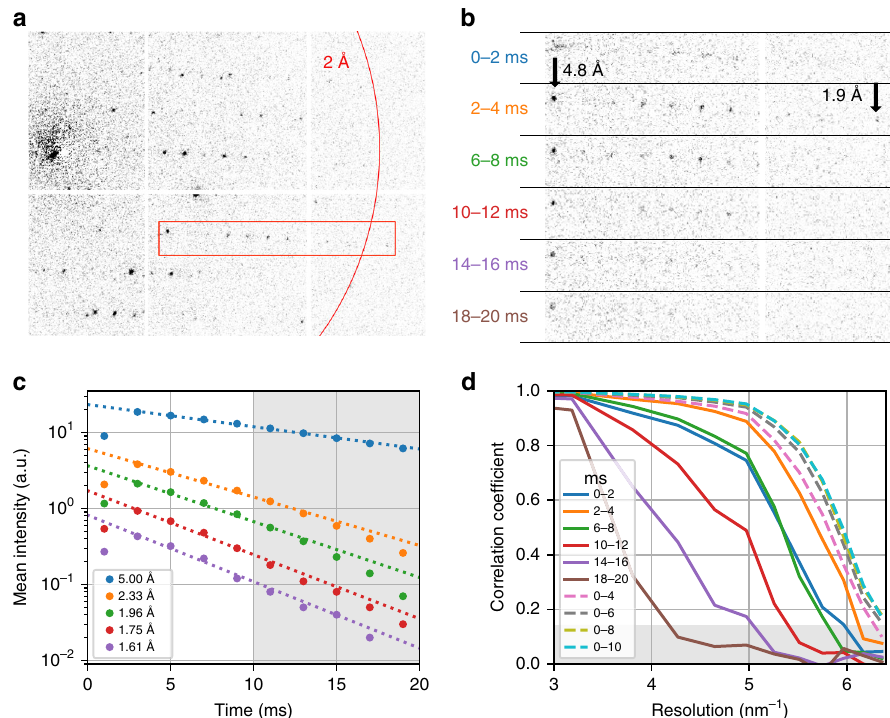
Fig. 3 Radiation damage during dose-fractionated acquisition. a Typical diffraction pattern from a granulovirus occlusion body. The red box indicates the enlarged region in b . b Enlarged diffraction pattern section for several single frames from the dose-fractionated movie stack, each of 2 ms duration. The integration time of each frame relative to the beam fi rst hitting the crystal is speci fi ed. Note the fading of the diffraction spots, especially at high resolutions. The fi rst shot is affected by residual beam motion and hence has a shorter effective integration time and shows blurring artefacts. c Mean intensity of Bragg re fl ections for different resolution shells as a function of delay time, and exponential fi t lines, where the fi rst time point has been excluded from the fi t. The shaded area corresponds to delay times beyond 10 ms, which have been excluded from our data analysis. d Resolution-dependent correlation coef fi cients CC 1/2 shown from 3.33 to 1.55 Å resolution. Solid lines correspond to single movie frames as in b . Dashed lines correspond to images that were cumulatively summed over several frames. The shaded area corresponds to values CC 1/2 <0.143, where data falls below the resolution cut-off at CC* =